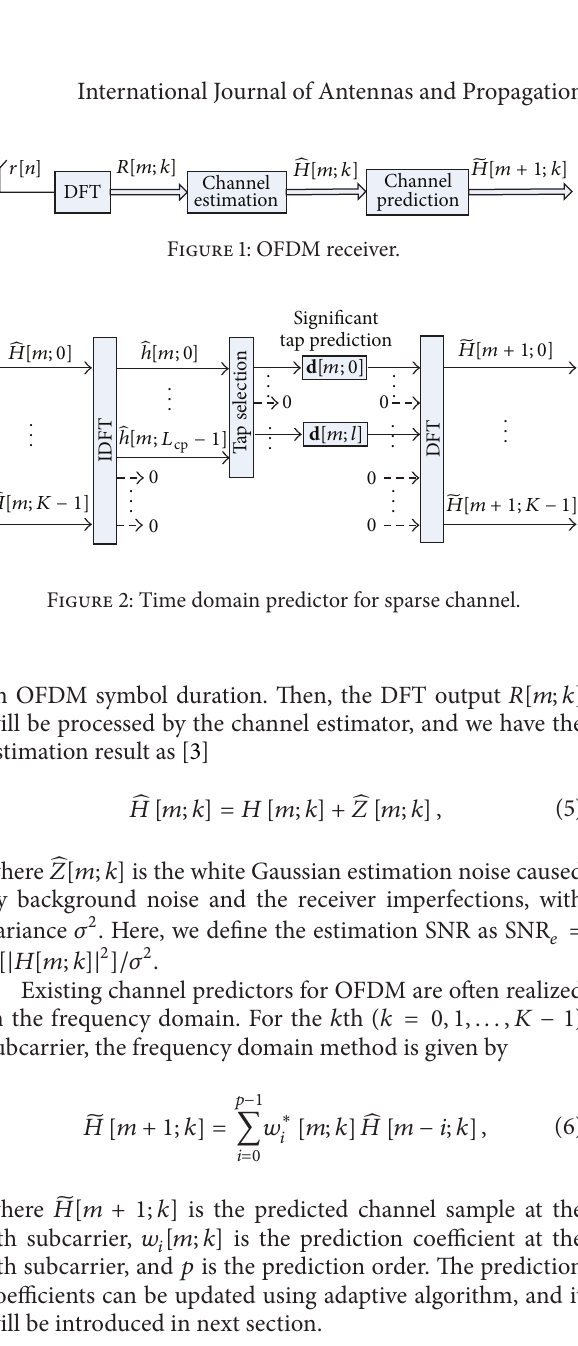
Figure 1: OFDM receiver.